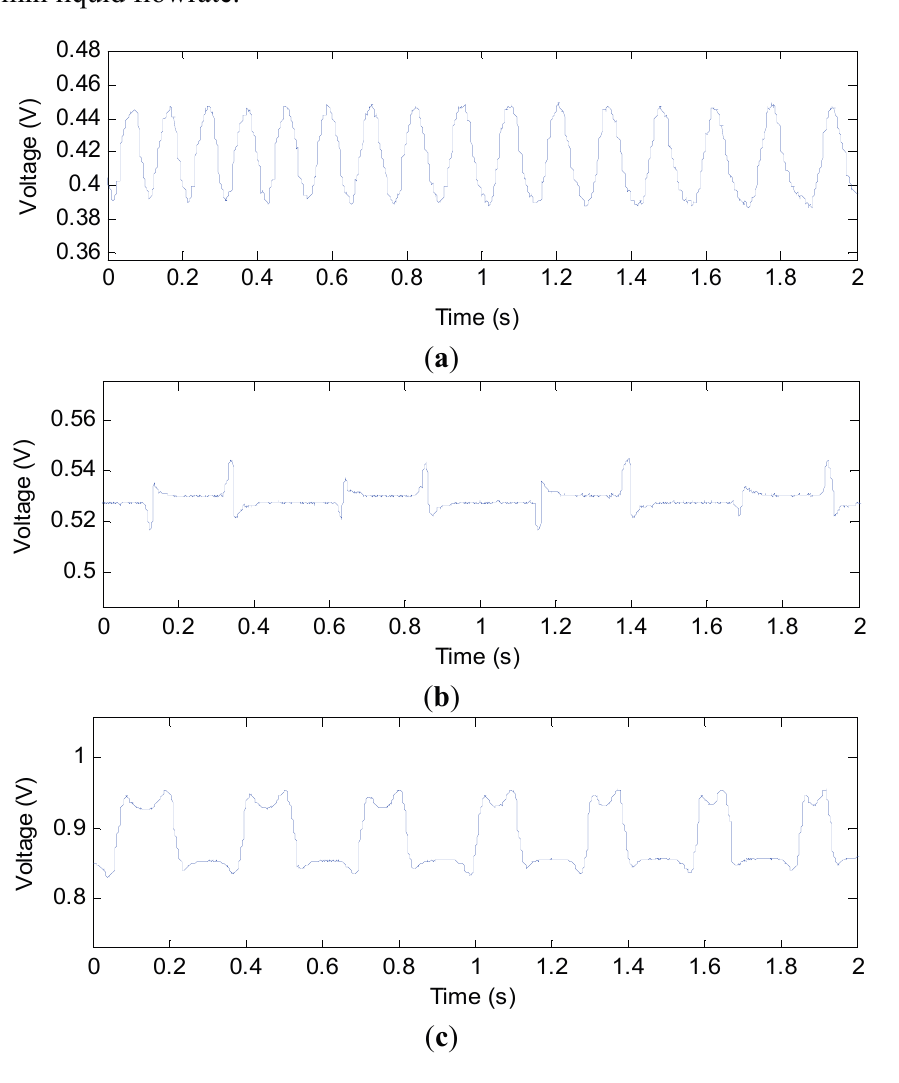
Figure 6. ( a ) Signal from capacitance sensor in 1.56 mm inner diameter pipe with 10.0 mL/min gas flowrate and 1.0 mL/min liquid flowrate; ( b ) Signal from capacitance sensor in 2.65 mm inner diameter pipe with 10.0 mL/min gas flowrate and 10.0 mL/min liquid flowrate; ( c ) Signal from capacitance sensor in 3.96 mm inner diameter pipe with 30.0 mL/min gas flowrate and 10.0 mL/min liquid